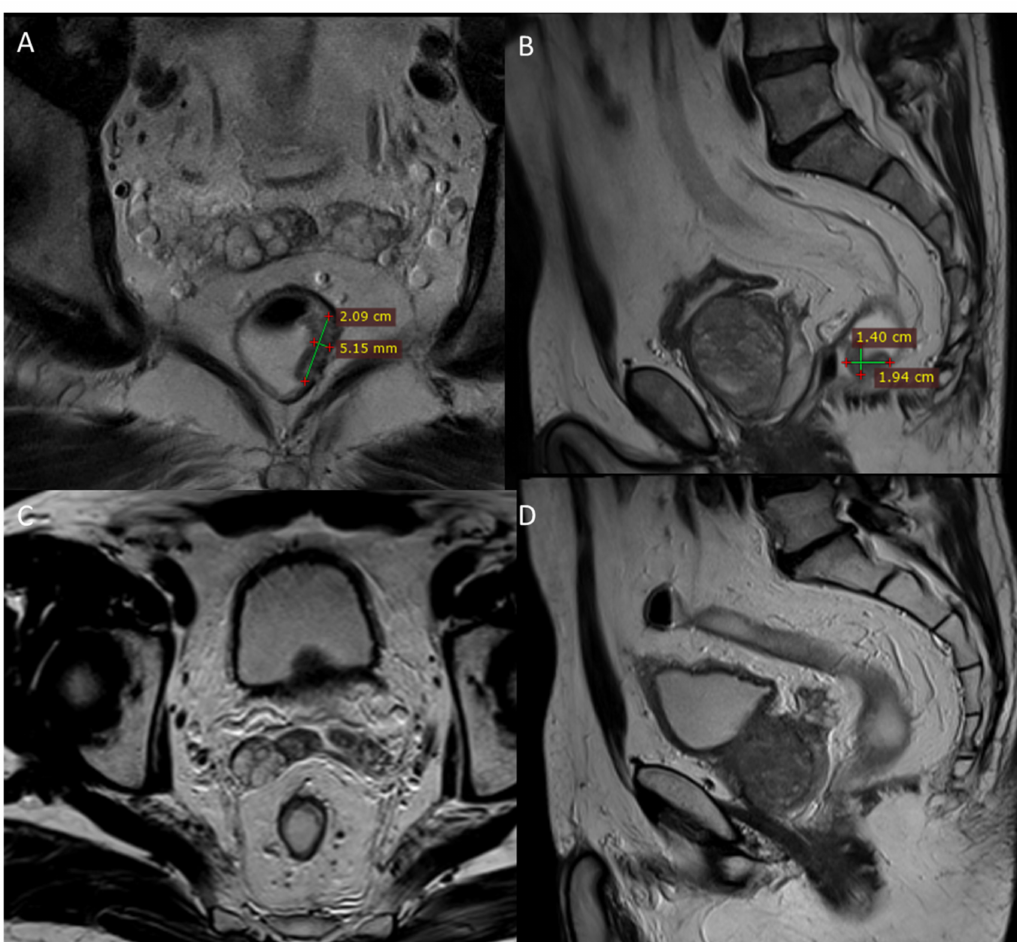
Figure 5. MR images ( A , B ) before treatment of second case and 2 months after ECT treatment ( C , D